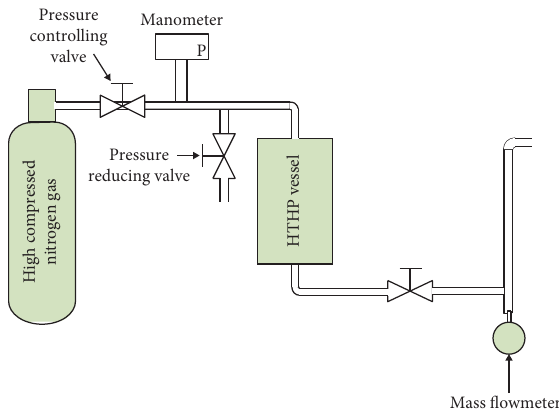
Figure 3: Flow chart of permeability